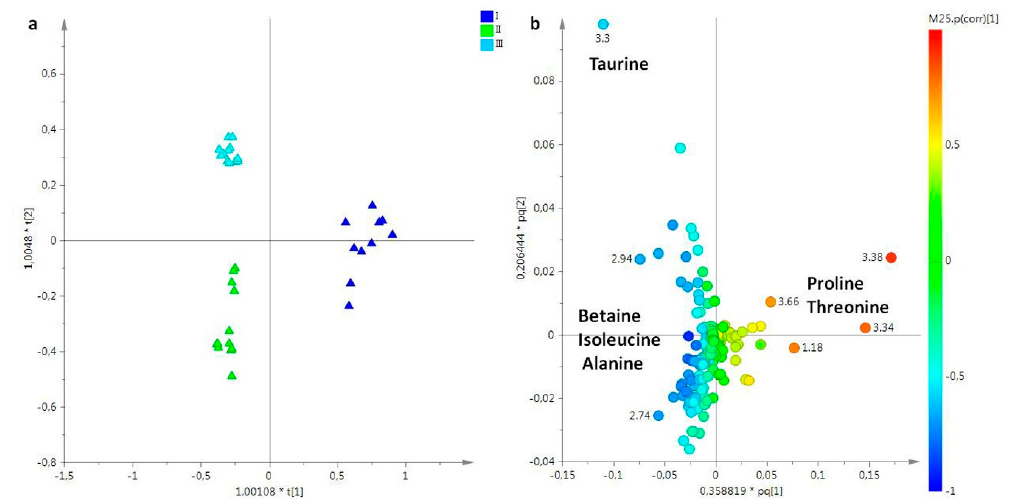
Figure 8. ( a ) OPLS-DA t[1]/t[2] scores plot of for aqueous extracts of umbrella of R.pulmo collected in different sampling periods: blue triangle, March sampling (I); green triangle, May sampling (II); sky blue triangle, July sampling (III). ( b ) Loading plot for the model; the variables indicated ppm in the 1 H NMR spectrum.